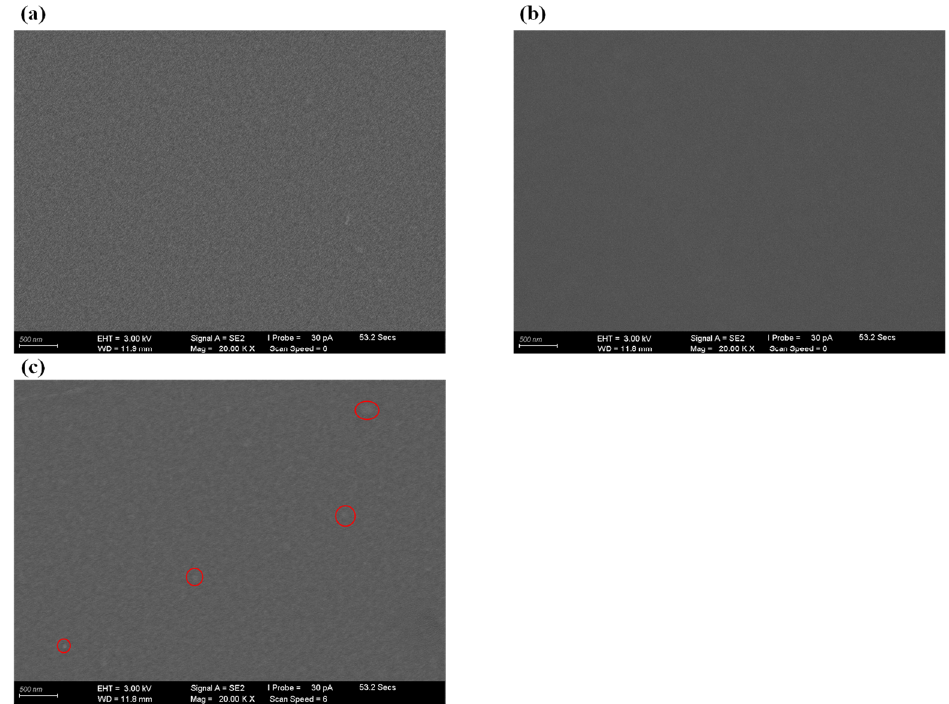
Figure 12. SEM images of PEDOT: PSS without and with different organic additives and subjected to multi-FA treatment: ( a ) PEDOT: PSS, ( b ) PEDOT: PSS-maltitol (4 wt%), ( c ) PEDOT: PSS-sorbitol- maltitol (3:1).